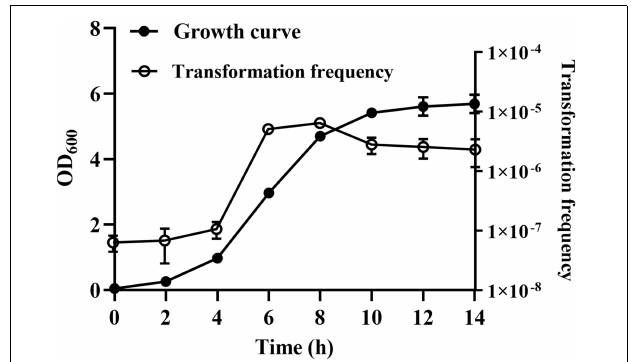
FIGURE 2 | The effect of different growth phases on natural transformation. R. columbina was cultured with shaking at an OD 600 of 0.05 for 14 h. The OD 600 value was determined every 2 h. Additionally, natural transformation was assessed every 2 h. The results are representative of three independent experiments. Error bars denote standard deviation.